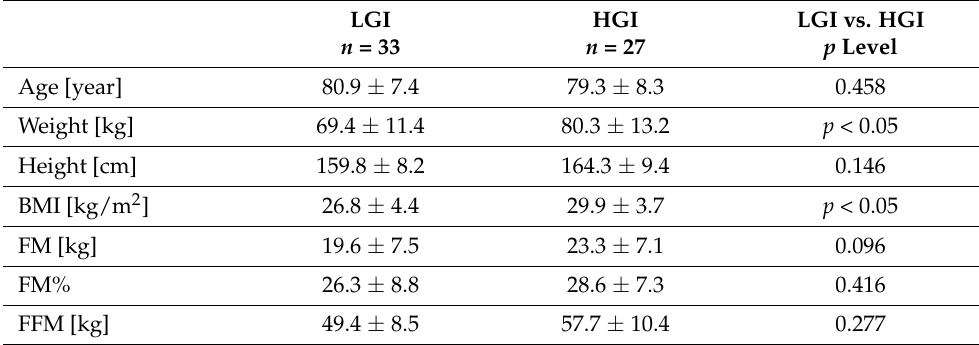
Table 2. Anthropometrics and body composition in low-grade inflammation (LGI) group and in high-grade inflammation (HGI) group (mean ±